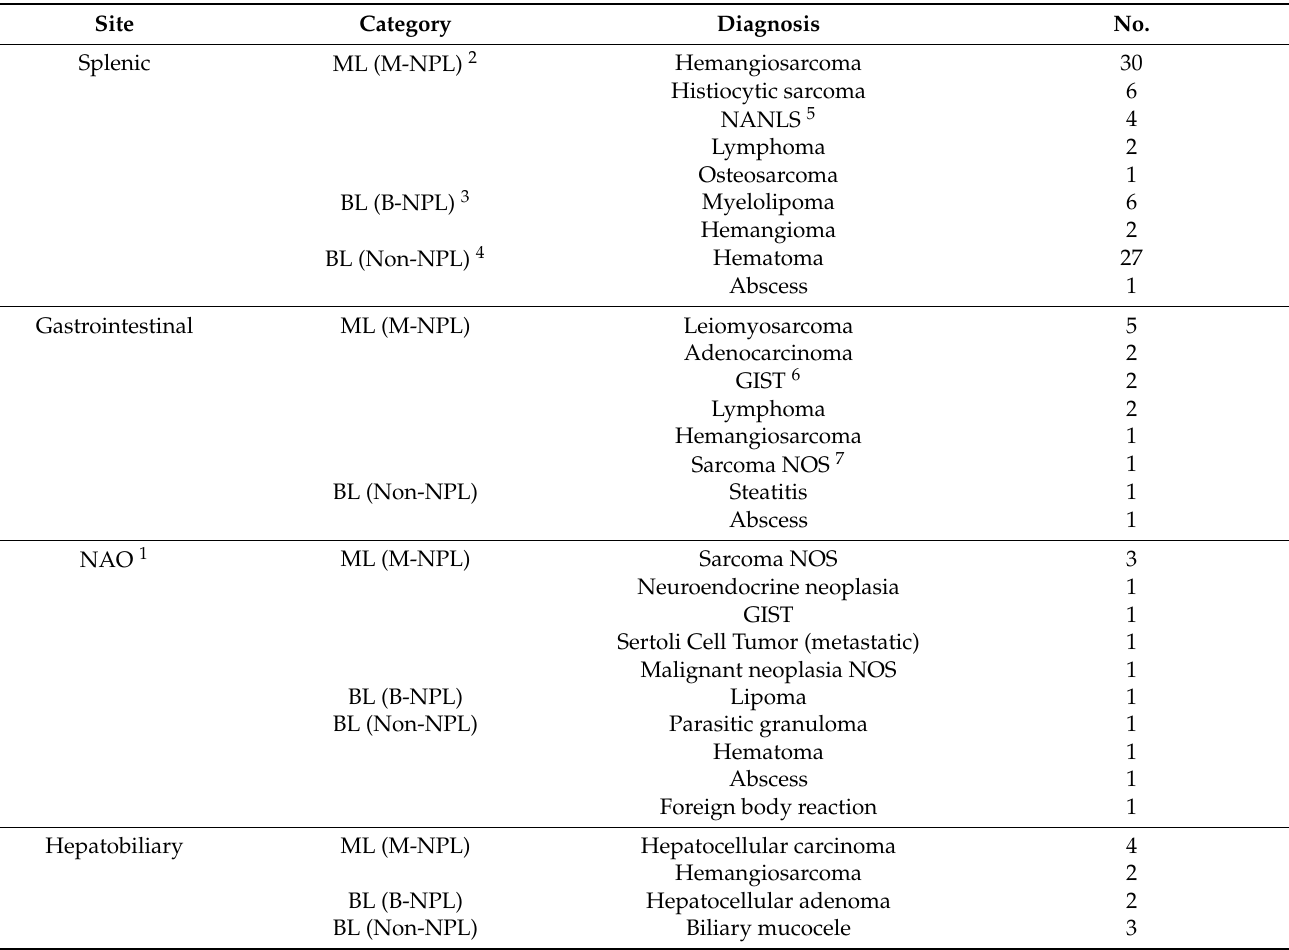
Figure 2. Histogram depicting the percentage of malignant neoplasias (M-NPLs) versus benign lesions (BLs) at different sites of occurrence. Table 2. Diagnoses of abdominal lesions in different